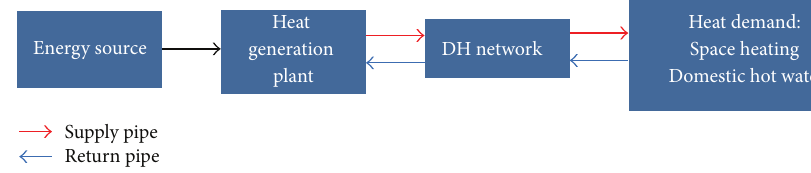
Figure 1: District heating block diagram.